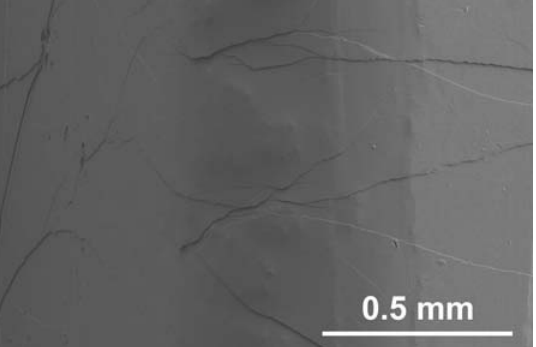
Figure 6. SEM image in secondary electrons of the lateral surface of the Zr Ni Cu Al glassy alloy sample after mechanical test at boiling 64.13 10.12 15.75 10 LN 2